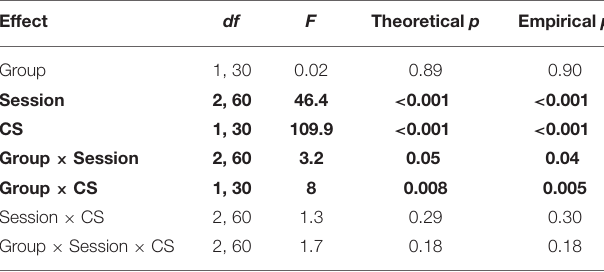
TABLE 4 | ANOVA of freezing time during memory trials.